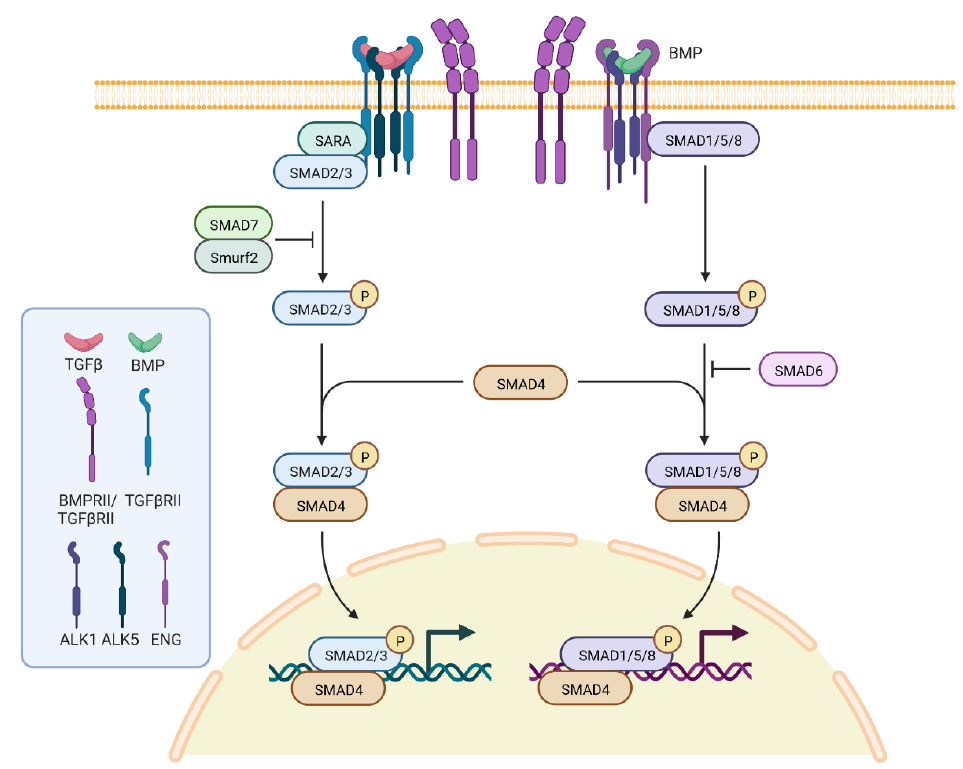
Figure 1. Pathway of TGFβ signaling pathway. The image has been obtained through BioRender; Carla Olivieri has been granted a license to use the BioRender content, including icons, templates, and other original artwork under agreement number RE243EDSFS.